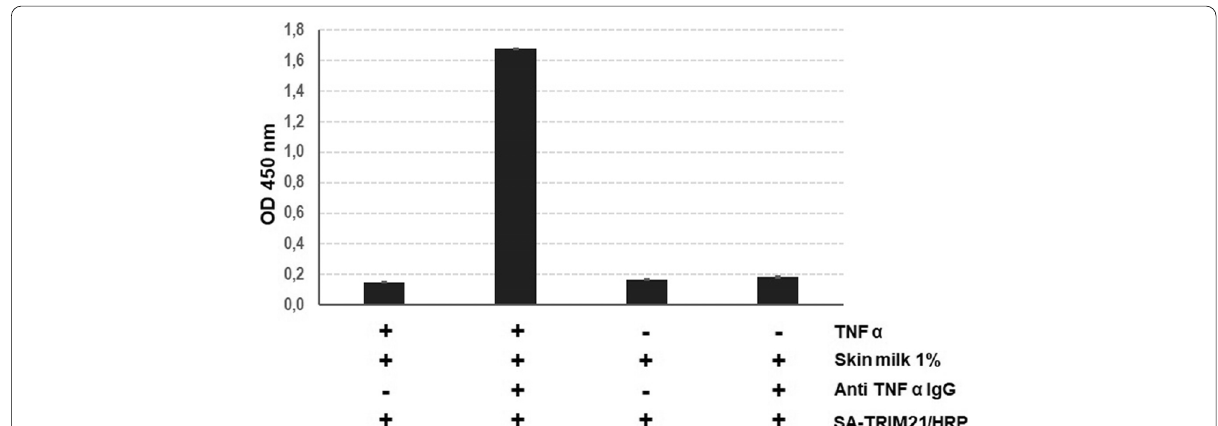
Fig. 3 TNF-α/Infliximab detection on indirect ELISA using SA-TRIM21. SA-TRIM21 (0.25 μg/well) and biotinylated HRP (1:5000) were added to the plates for TNF α/Infliximab complex